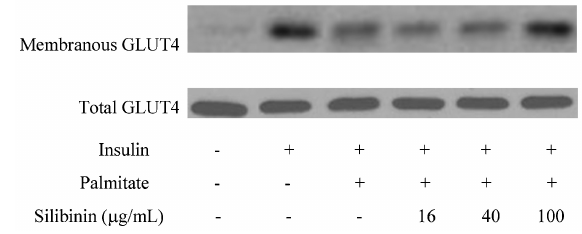
Figure 3. Effects of silibinin on insulin-stimulated GLUT4 translocation in palmitate-treated C2C12 myotubes. C2C12 myotubes were incubated with palmitate (0.75 mM) or silibinin + palmitate as described in Methods. Before harvesting, the cells were incubated in the presence or absence of 100 nM insulin for 30 min and lysed for Western blotting. Figures are representative of 3 independent